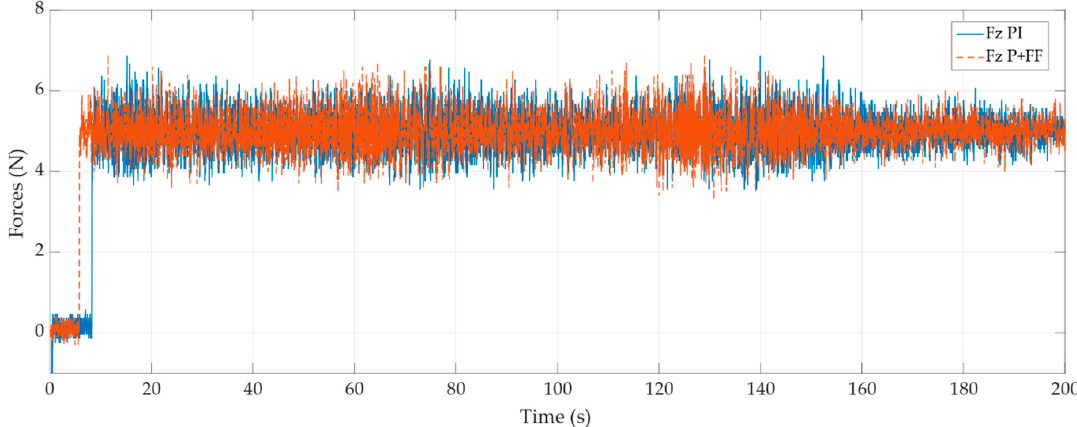
Figure 10. Integral action (PI) vs. feedforward action (P + FF) comparison.